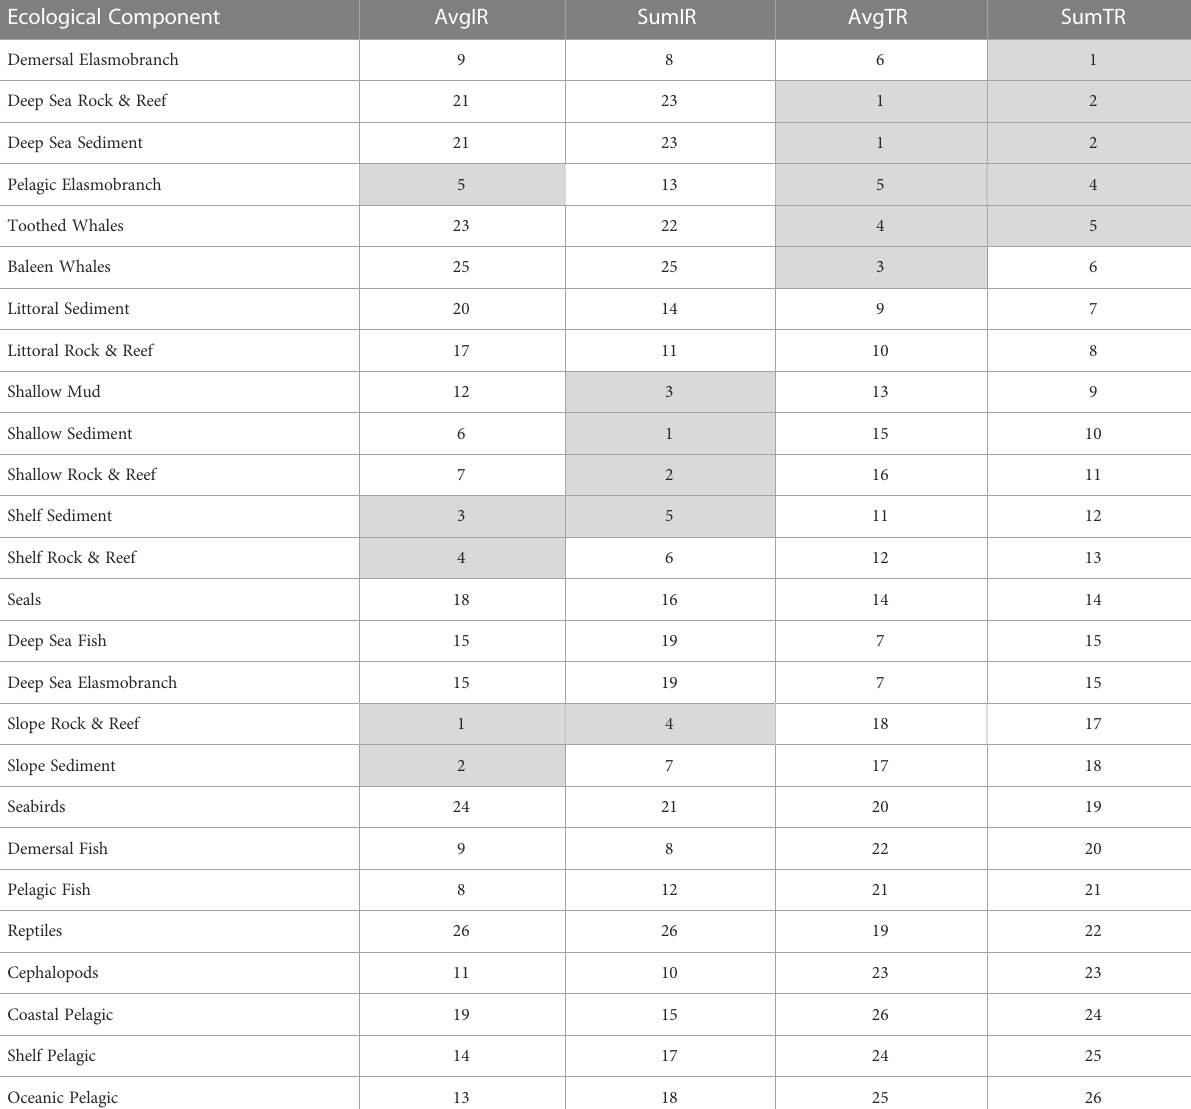
TABLE 5 Ranks for each Ecological Component and ranking index used. Ecological Component AvgIR